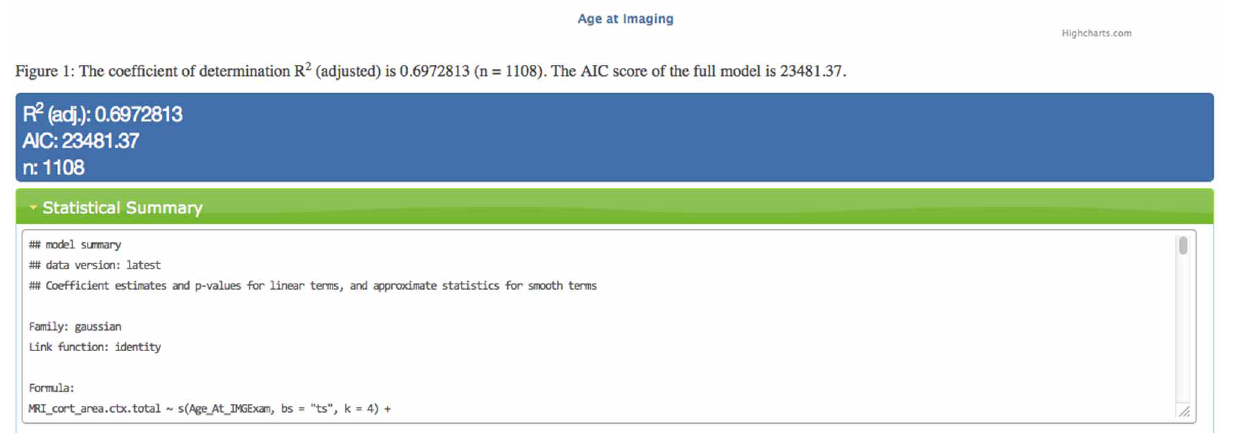
shown above the scatter plot. The model is executed on the server using R after selecting the “Compute Model” option. Resulting model curves and residualized data points are plotted together with summary statistics in the middle and lower parts of the web-page. The scatter plot supports an interactive legend, changes in magnification, and data points that link back to imaging